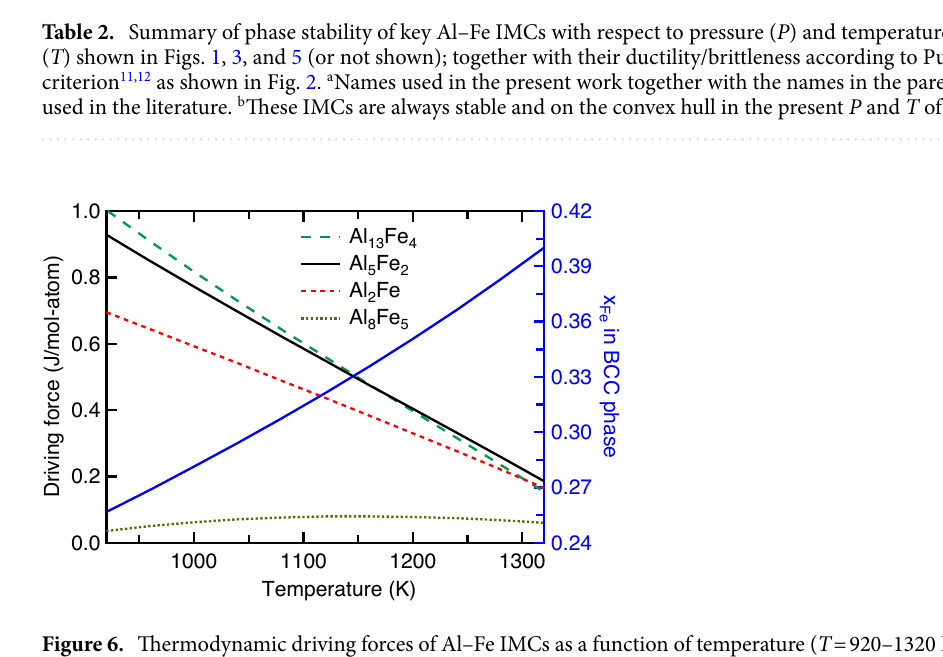
Table 2 summarizes phase stability of Al–Fe IMCs as a function of pressure and temperature as shown in Figs. 1, 3, and 5; together with their ductility/brittleness judged by Pugh’s criterion 11,12 as shown in Fig. 2, which were determined by the presently predicted elastic constants in Table S3.